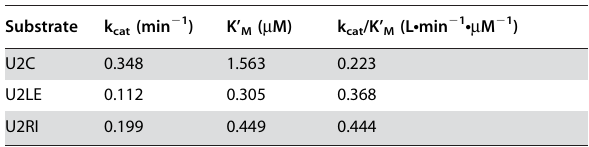
Table 1. Kinetic parameters of Rnt1p cleavage of U2